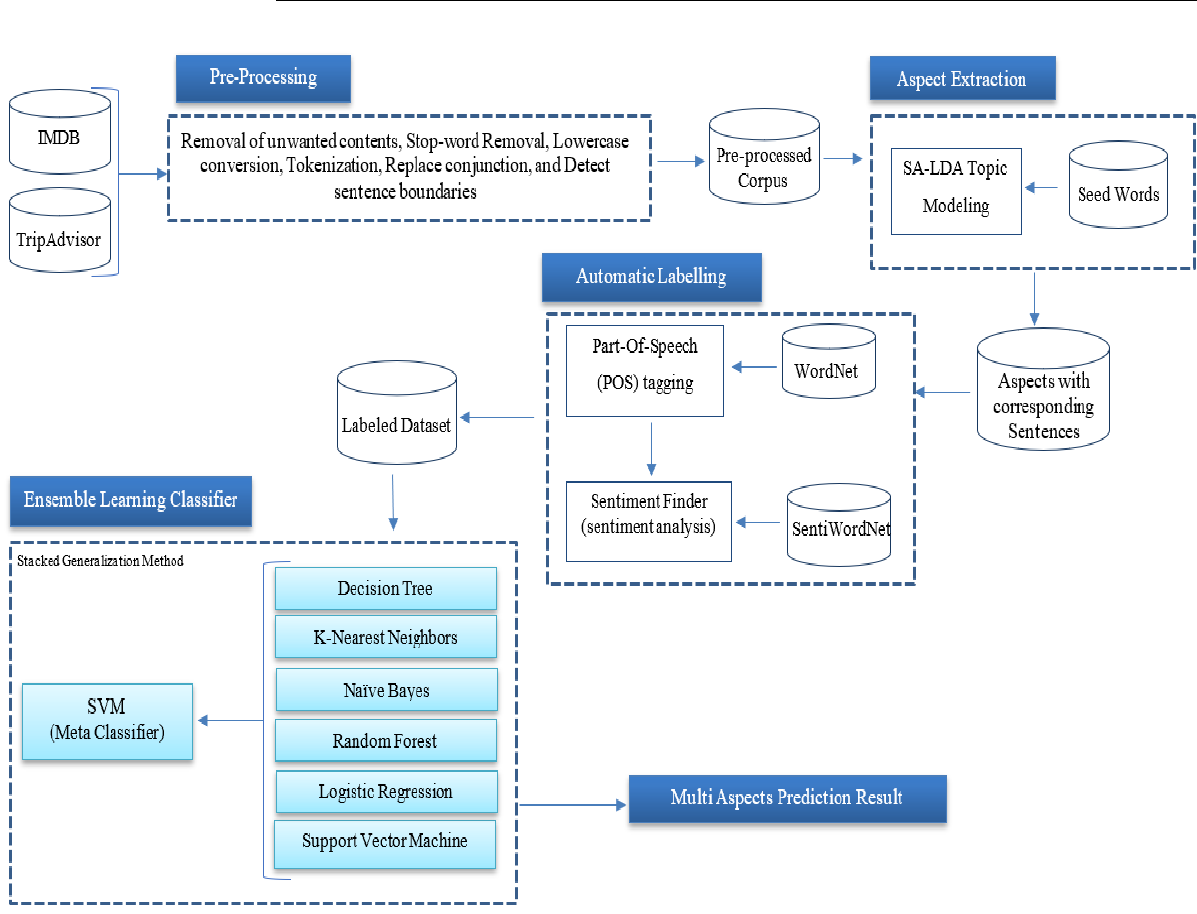
Figure 1. The architecture of the proposed framework.